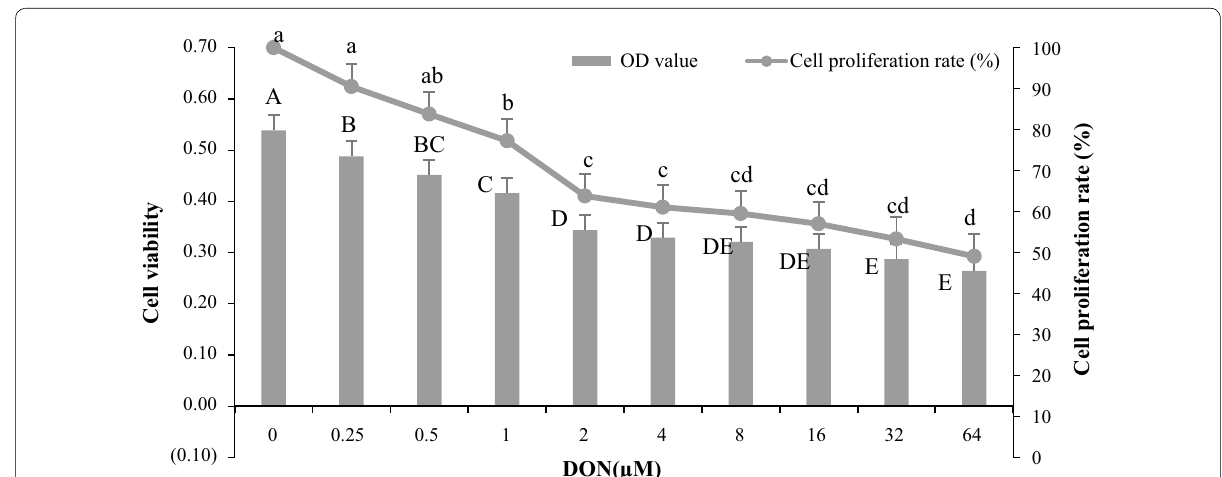
Fig. 1 Effect of different DON concentrations on IPEC‑J2 cell viability and proliferation rates after 24 h incubation. The different capital letters indicated the significant differences for cell viability among the different groups ( p < 0.05), while the same capital letters indicated the insignificant differences for cell viability among the different groups ( p > 0.05). The different lowercase letters indicated the significant differences for cell proliferation rates among the different groups ( p < 0.05), while the same lowercase letters indicated the insignificant differences for cell proliferation rates among the different groups ( p > 0.05)